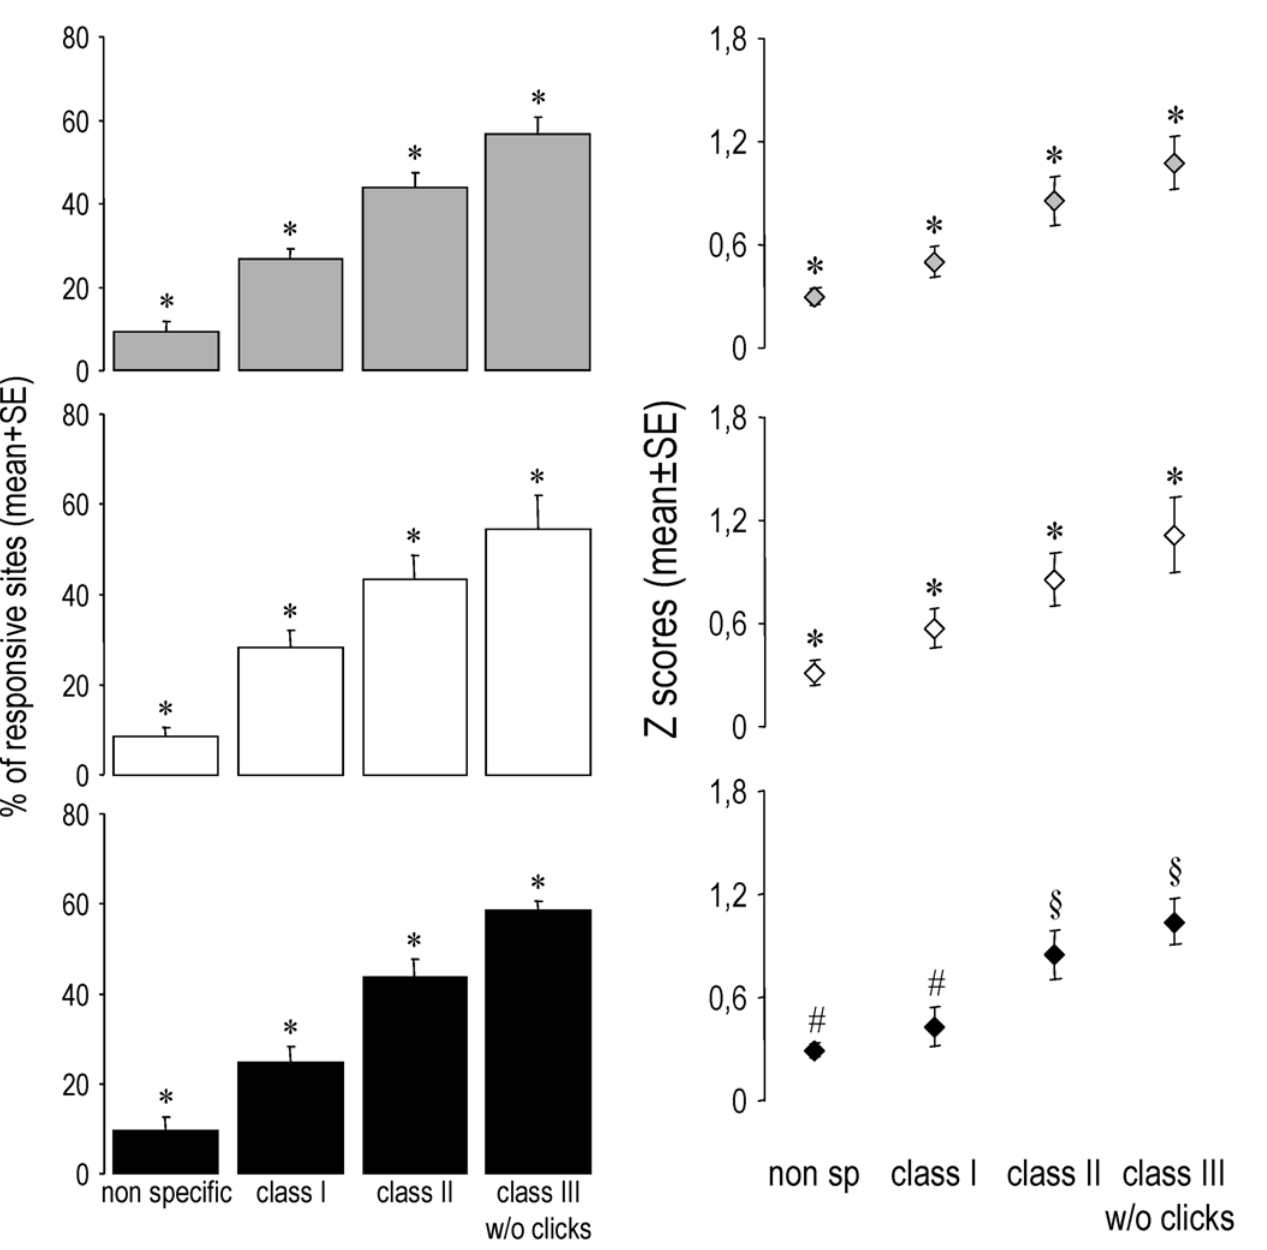
Figure 4. Mean ( + SE) percentage of responsive sites that responded to each class of stimulus. Grey bars: pooled data of both hemispheres; white bars: data of the left hemisphere; black bars: data of the right hemisphere. * p , 0.001 compared to every other groups (PLSD Fisher tests).